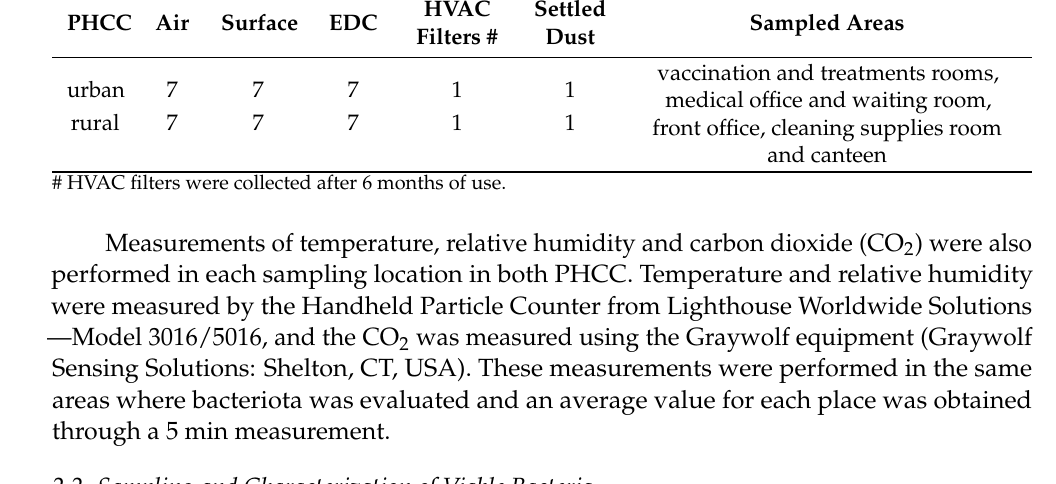
Table 1. Sampled performed and areas assessed in each PHCC. PHCC Air Surface